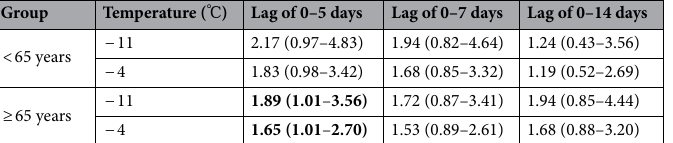
Table 3. Cumulative RRs of lower temperature with CAP hospitalizations by different lag days. Bold estimates are statistically